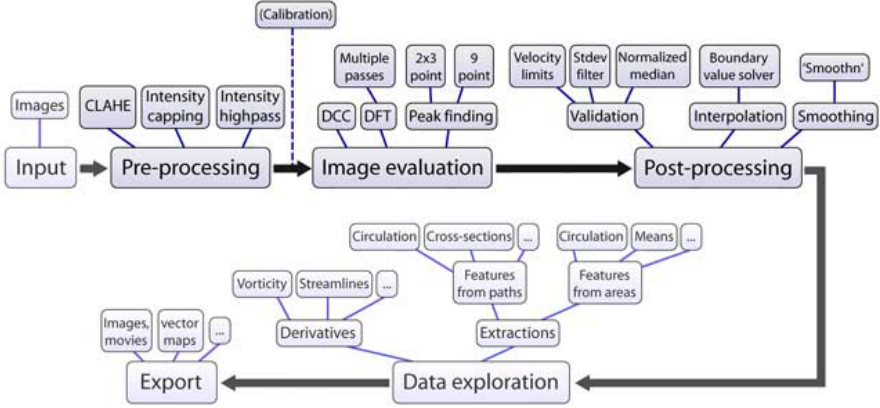
Figure 5. Overview of the workflow in PIVlab and the implemented features